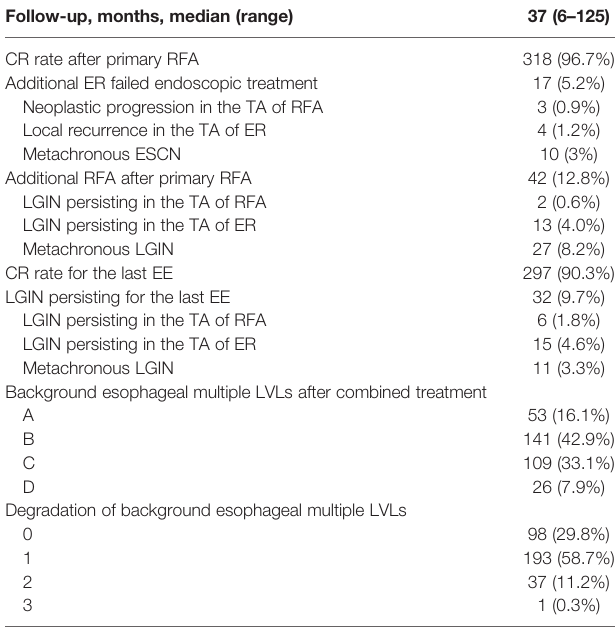
TABLE 2 | Tumor characteristics and pathological results of endoscopic treatment. Location within esophagus